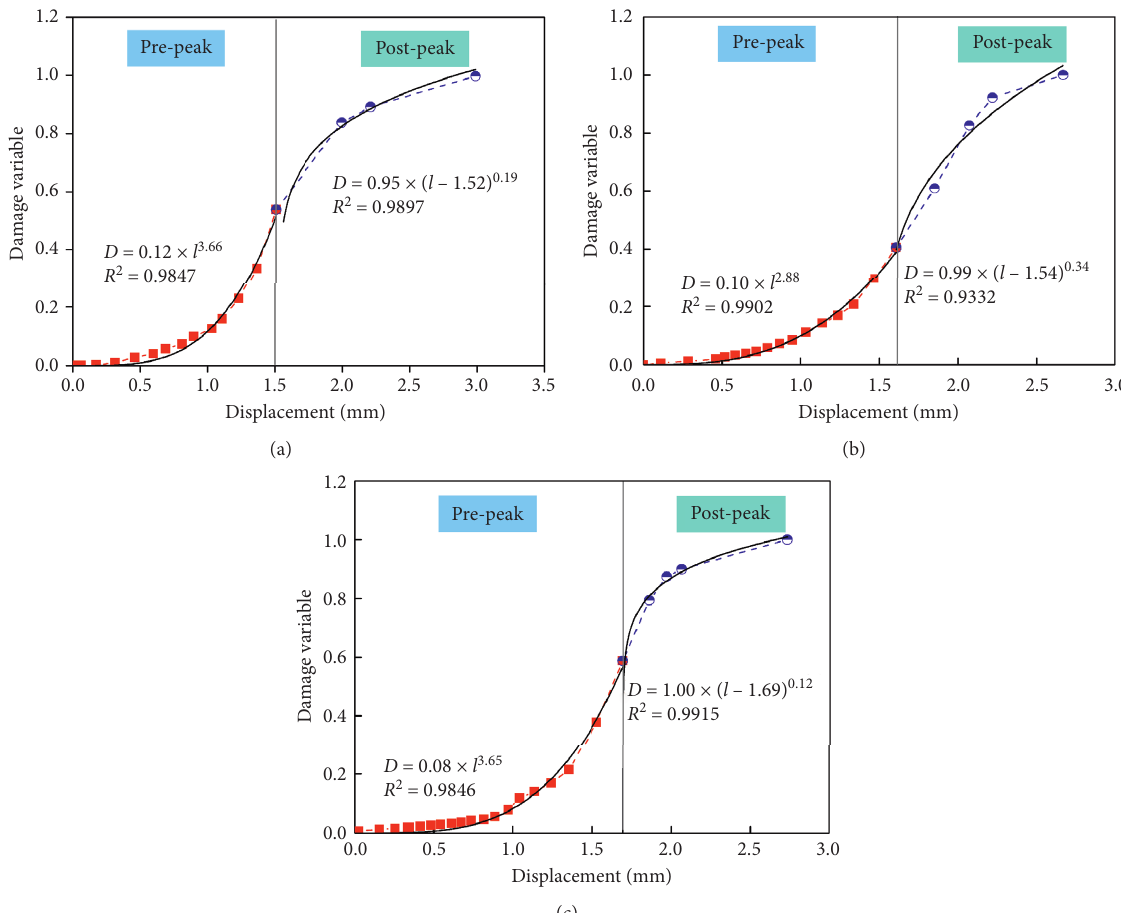
Figure 9: Fitting results of damage variable-displacement curves. (a) Specimen f-1; (b) specimen f-2; (c) specimen